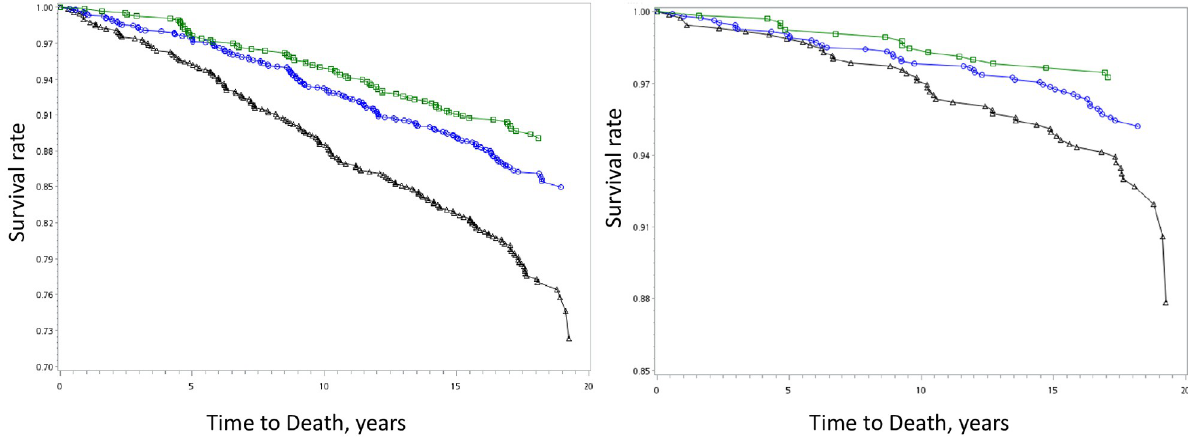
Fig 1. Survival Curves of The Healthy Taiwanese Eating Approach for (a) total and (b) cardiovascular mortality. A significant difference existed among three groups in total and cardiovascular mortality (both p-value less than 0.05). Taiwanese Eating Approach were classified into three groups, group 1 (black triangle, poor diet), group 2 (blue circle, average diet), and group 3 (green square, healthy